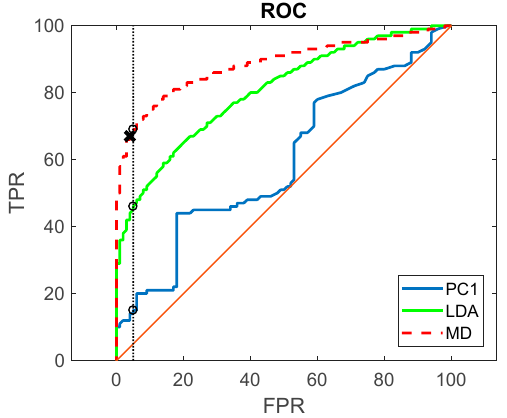
Figure 17. ROC curves for the three classifications considering the whole dataset involving both speed and load variability (all the 17 conditions in Table 3). The 5% significance threshold values are highlighted with the black circles; the black x denotes the position of the NI threshold computed according to the MC repetition introduced in Section 2.4.1. Table 11. MD confusion matrix for the whole dataset involving both speed and load variability. The 5% significance threshold highlighted in Figure 17 is used, as highlighted by the 0A false alarms rate of 5% .